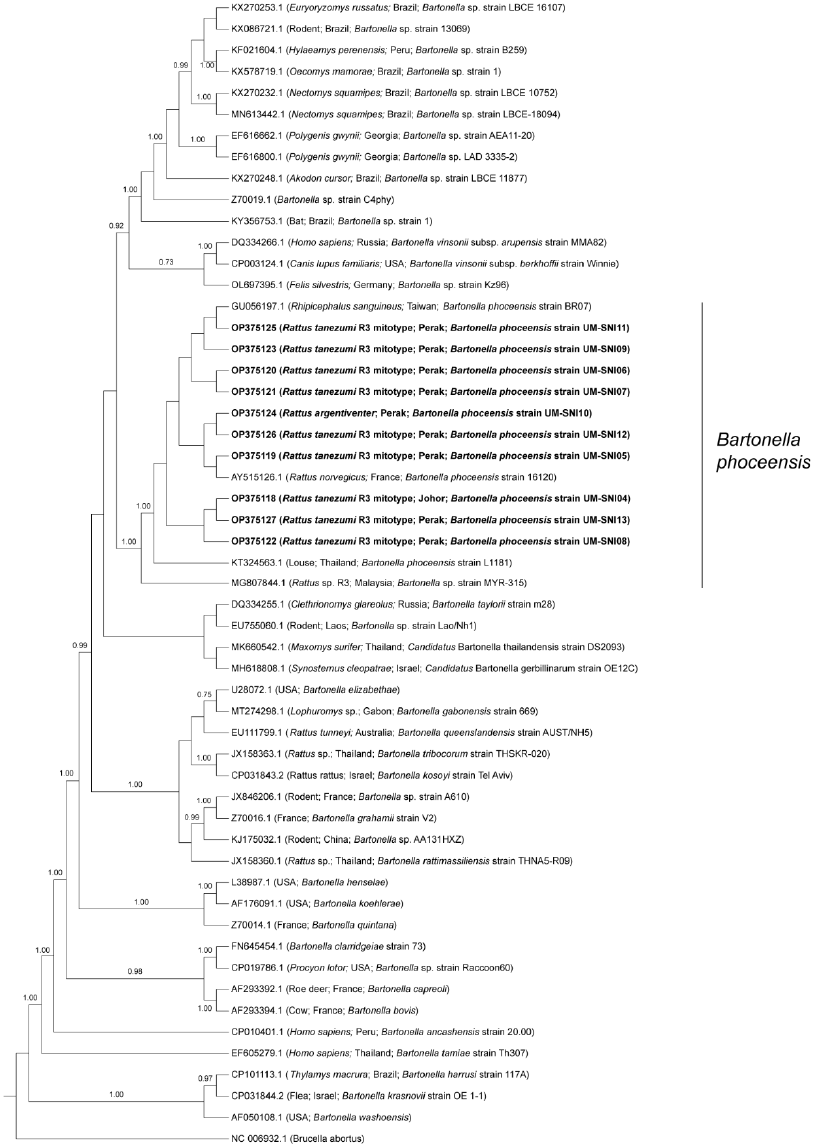
Figure 3. Bayesian inference phylogenetic tree of B. phoceensis based on the partial sequences (338 bp) of the gltA gene. Posterior probability (PP) is shown on the branches. Only PP > 0.7 are shown. Newly generated sequences are in bold text, with their accession numbers followed by the animal host species, location and strain name in parentheses. The reference sequences are labelled with their accession numbers followed by the host, location and Bartonella spp. strain in parentheses (some only contain partial information).